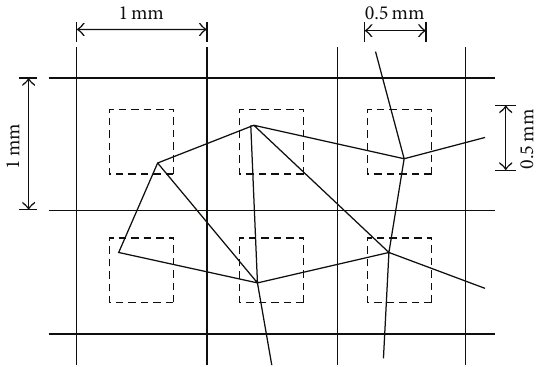
Figure 12: Schematic diagram of random lattice from 2D direction. After Schlangen [32].